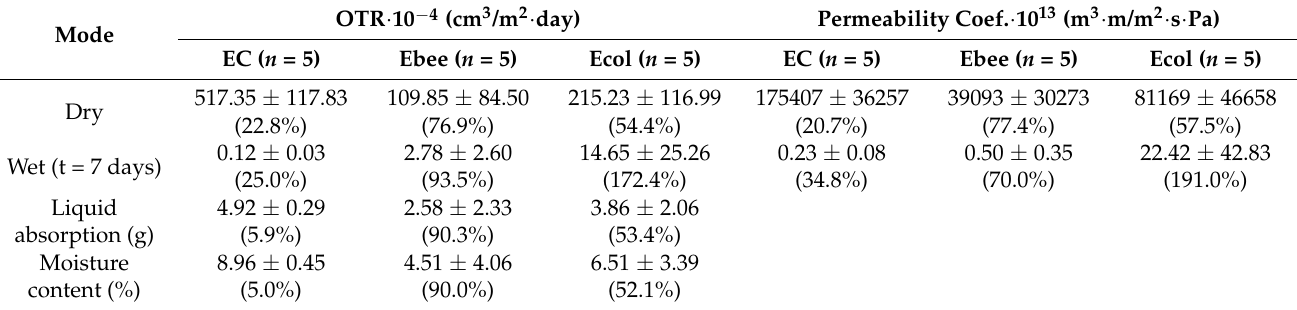
Table 1. Main permeation characteristics of tested Spanish earthenware samples with different coating treatments. Mode